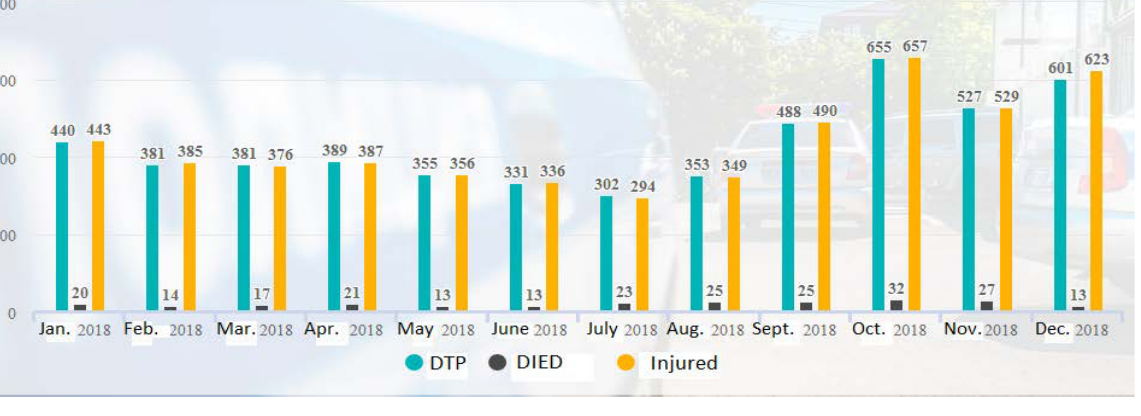
Fig. 3. At regulated pedestrian crossings.